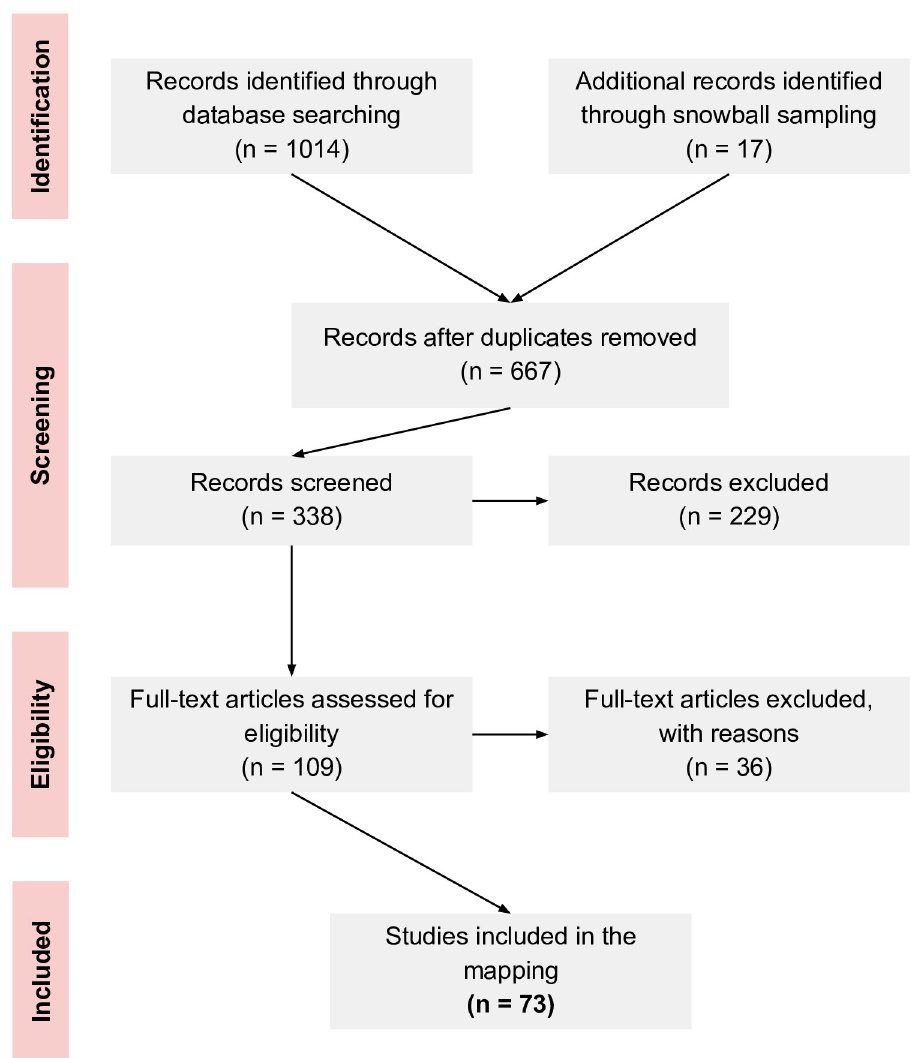
Fig 1. Study selection